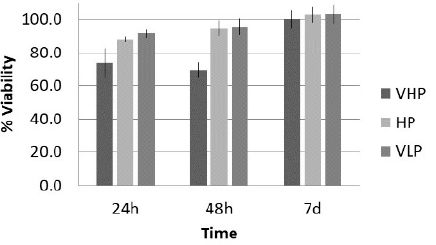
Figure 6. Viability (%), with respect to control, at 24 h, 48 h, and 7 d after treatment of fibroblasts with the long pulse protocol.